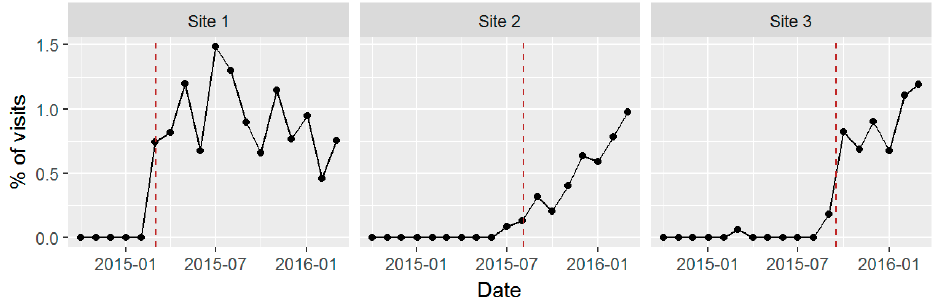
Figure 2. Screening for unhealthy alcohol use: percentage (%) of visits with screening by week, among providers implementing Behavioral Health Integration including the Sustained Patient-centered Alcohol-related Care (SPARC) program within three PC sites.